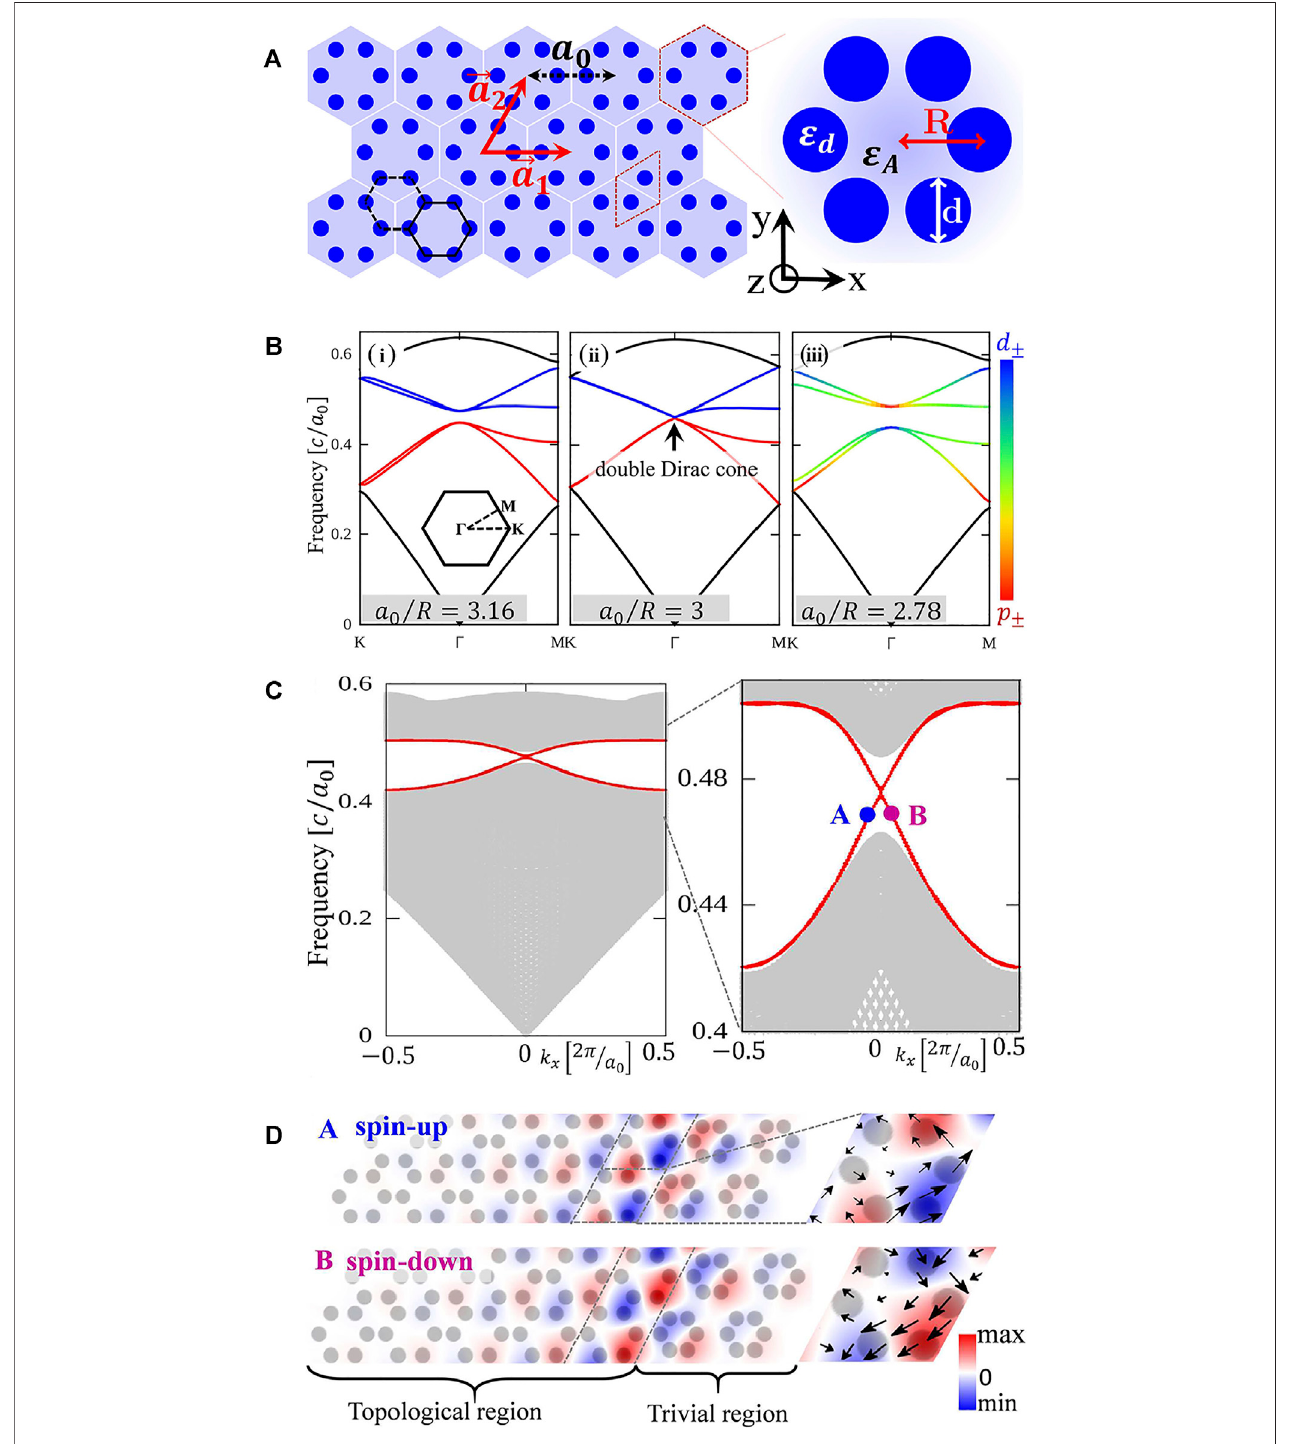
FIGURE 1 | (A) Topological photonic crystal structure with honeycomb lattice composed of six cylindrical pillars in each unit cell [84]. (B) Band structure in the fi rst Brillouin zone for transverse electromagnetic mode with expanding or shrinking the honeycomb lattice. (C) Dispersion relation in the topological interface. The gray regionsindicatebulkmodesandtheredcurvesindicatetopologicaledgestateswithinthebandgap. (D) Distributionofelectric fi eldintensityE z atAandBpointsmarked in (C) .